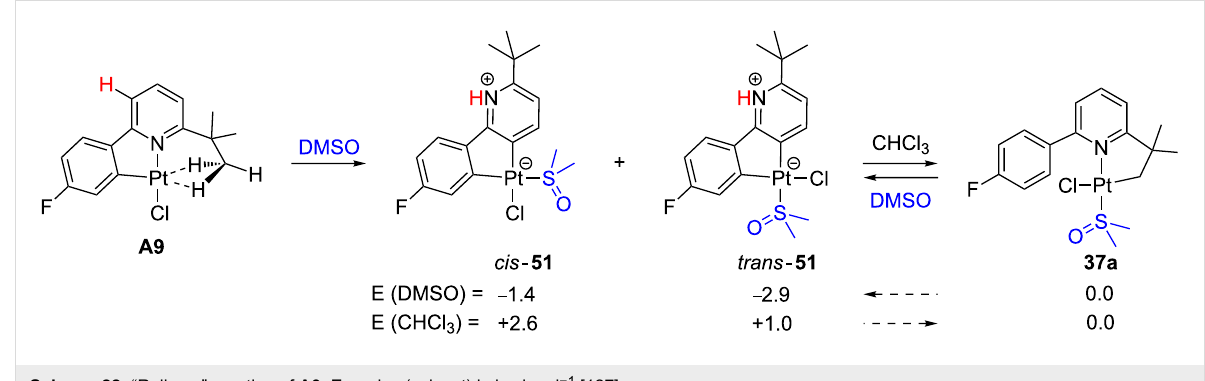
Scheme 22: “Rollover” reaction of A9 . Energies (solvent) in kcal mol − 1 [127].